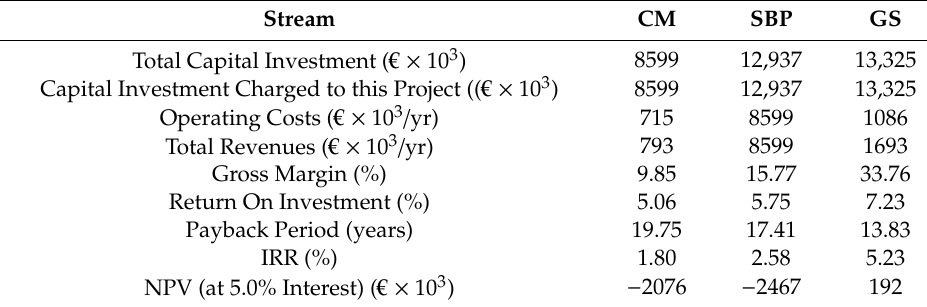
Table 15. Viability of biogas power plant excluding subsidy.